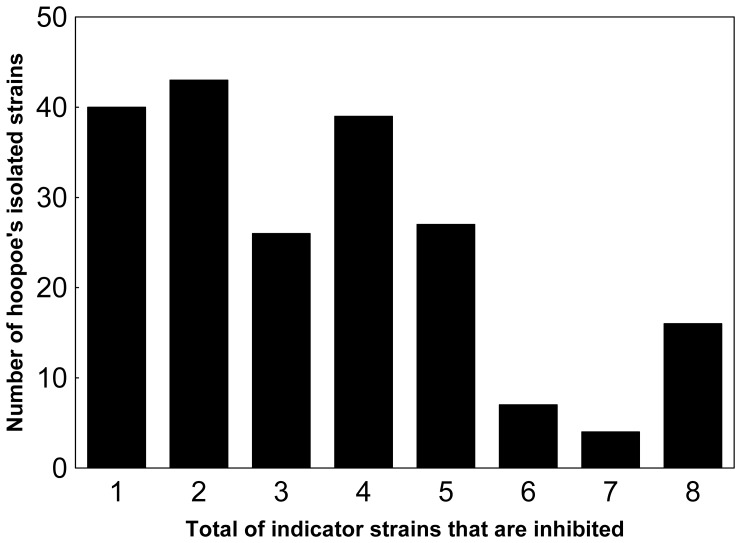
Antimicrobial activity rate.Variation in the number of symbiotic colonies isolated from hoopoe’s uropygial gland secretion that presented antagonistic activity against indicator bacteria.